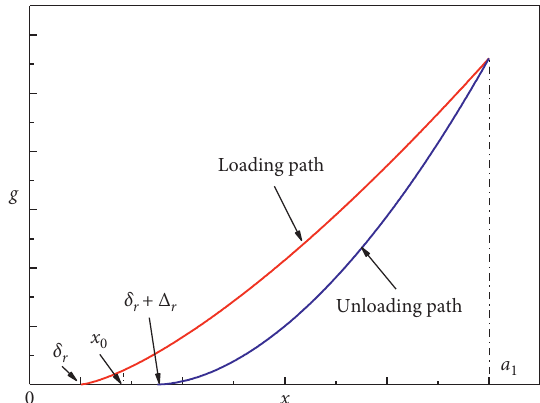
Figure 2: The constitutive relationship of the phenomenological impact